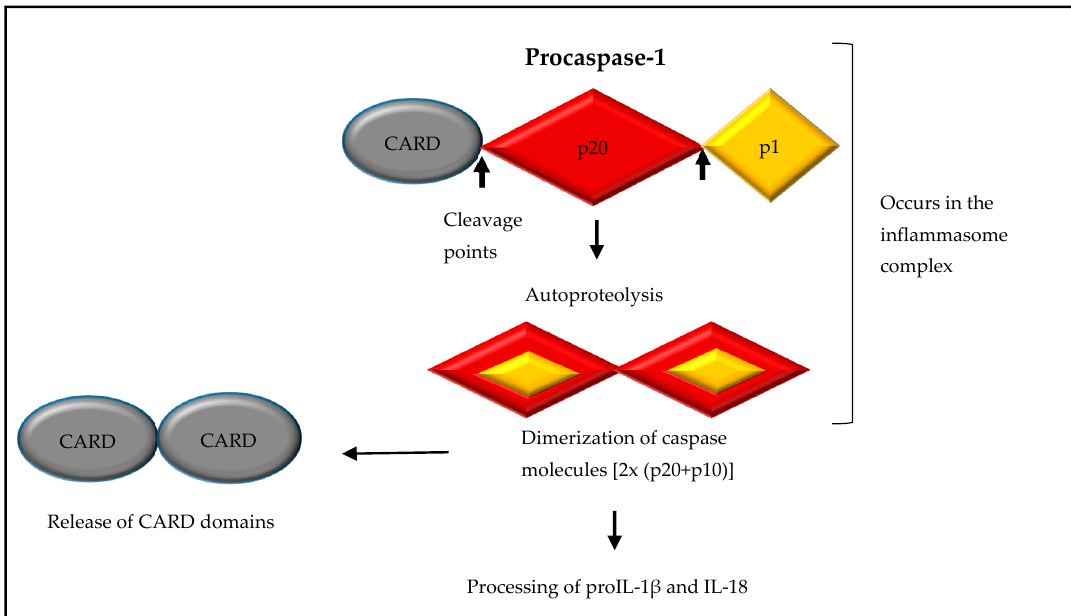
Figure 3. The mechanism for the inflammasome-mediated, catalytic conversion of procaspase-1 to caspase-1. NLRP1 inflammasome formation is strictly dependent on autolytic proteolysis within the